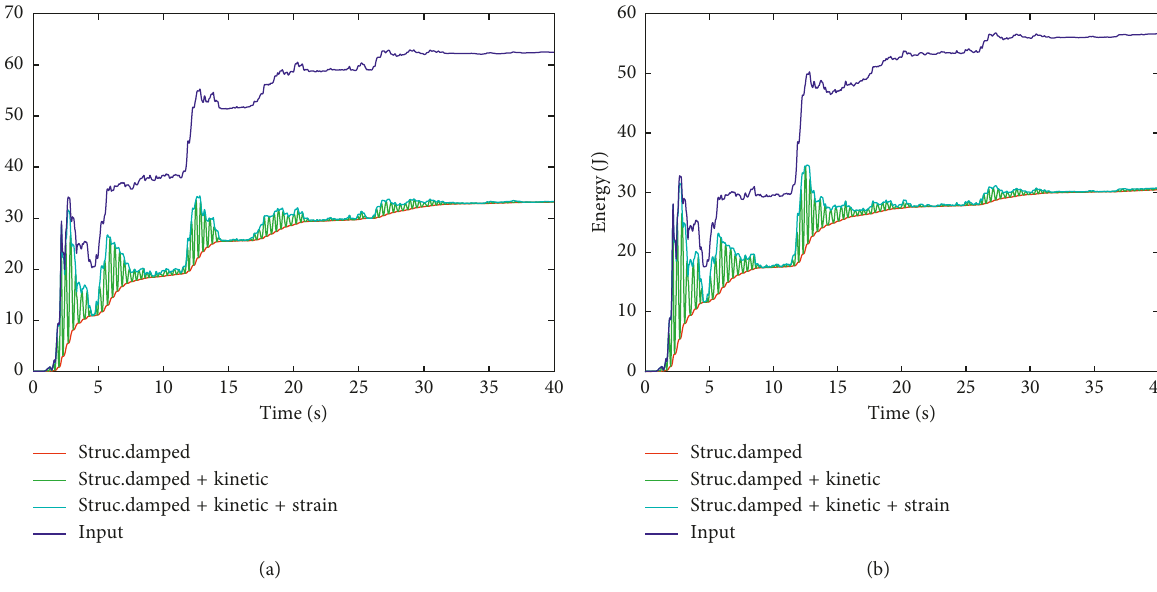
Figure 10: Input and dissipated energy of the controlled structure under El Centro earthquake with a (a) PTRMD and (b) PMD. Table 2: Comparison of control performance between PTRMD and PMD under earthquake excitation.